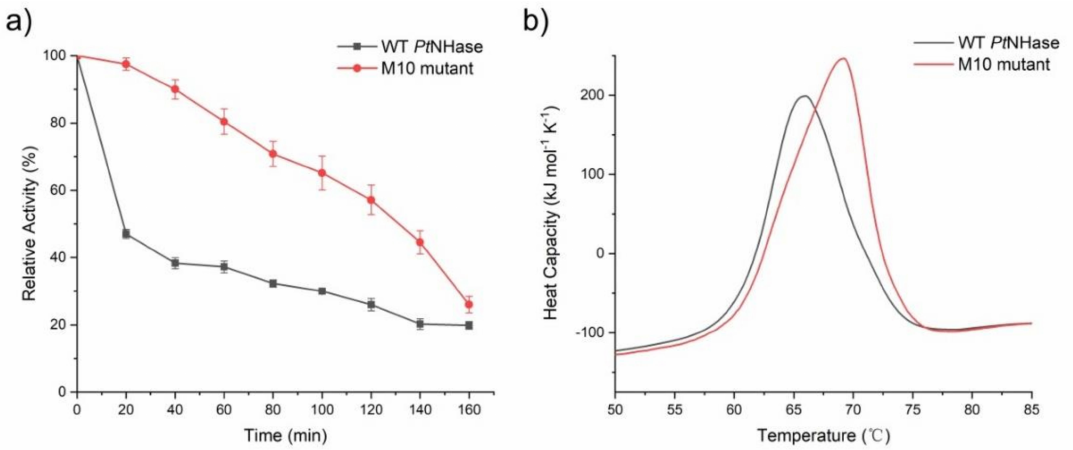
Figure 3. Half-life time determination and T m value measurement of WT Pt NHase and its M10 mutant. ( a ) Half-life time determination of WT Pt NHase and its M10 mutant. ( b ) Nano DSC scan results of WT Pt NHase and its M10 mutant. The heat capacity results were analyzed using the Nano DSC analysis software, and the T m values were calculated from a fitted